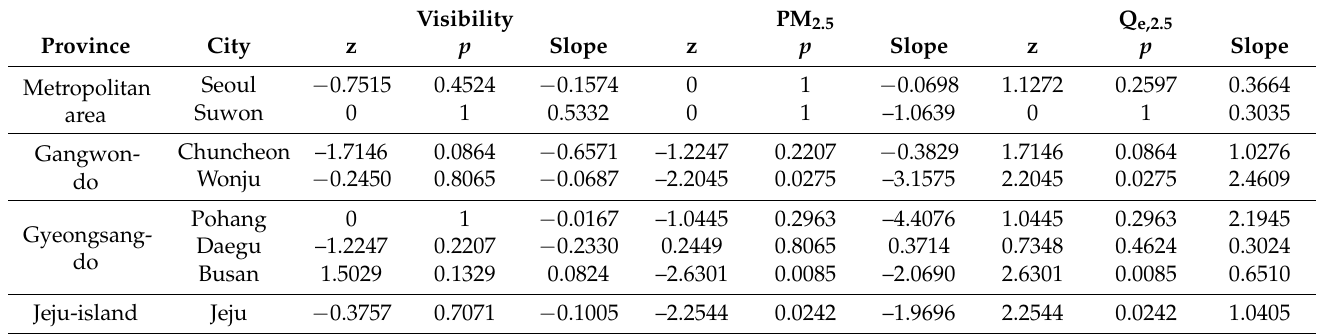
Table 3. MK Test and Sen’s slope for visibility, PM 2.5 and Q e,2.5 annual trend 2015–2020 (clear trend with 95% confidence level for |z| > 1.96 and 99% confidence level for |z| > 2.57). There were few data available for analysis of annual trends for Suwon and